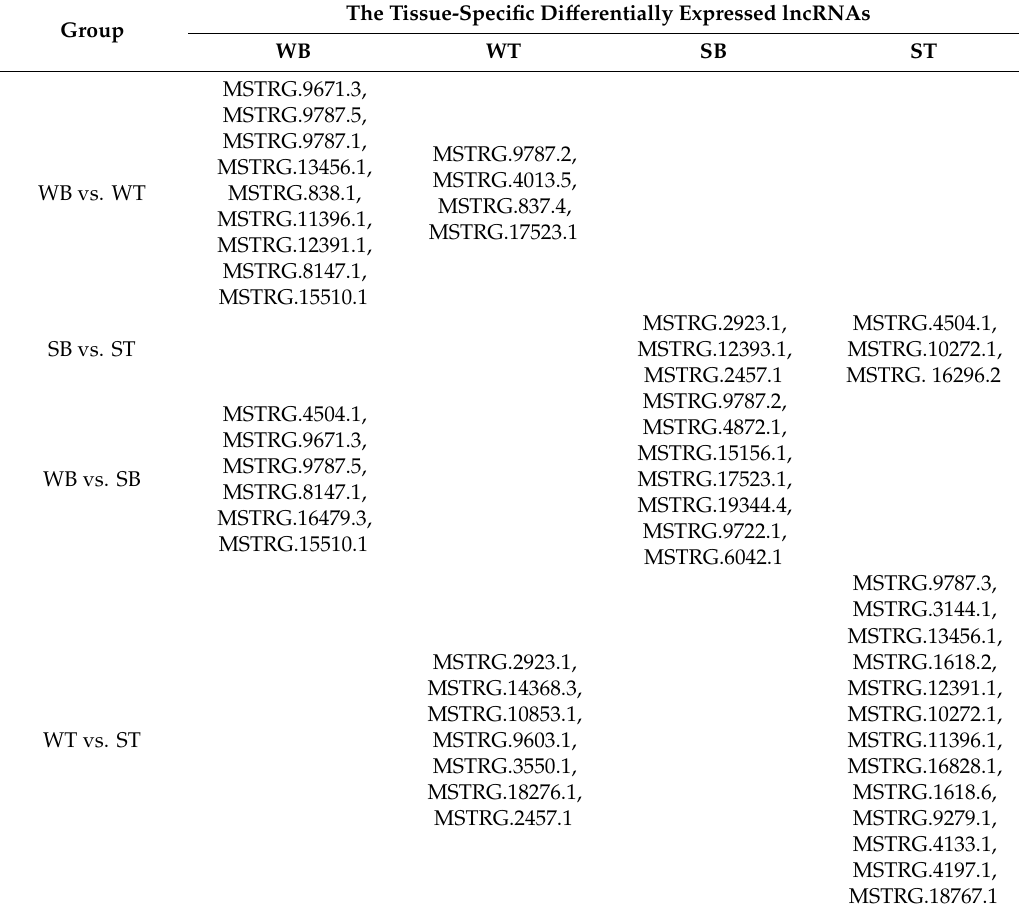
Table 4. The tissue-specific di ff erentially expressed lncRNAs in di ff erent strains and tissues. The Tissue-Specific Di ff erentially Expressed Group